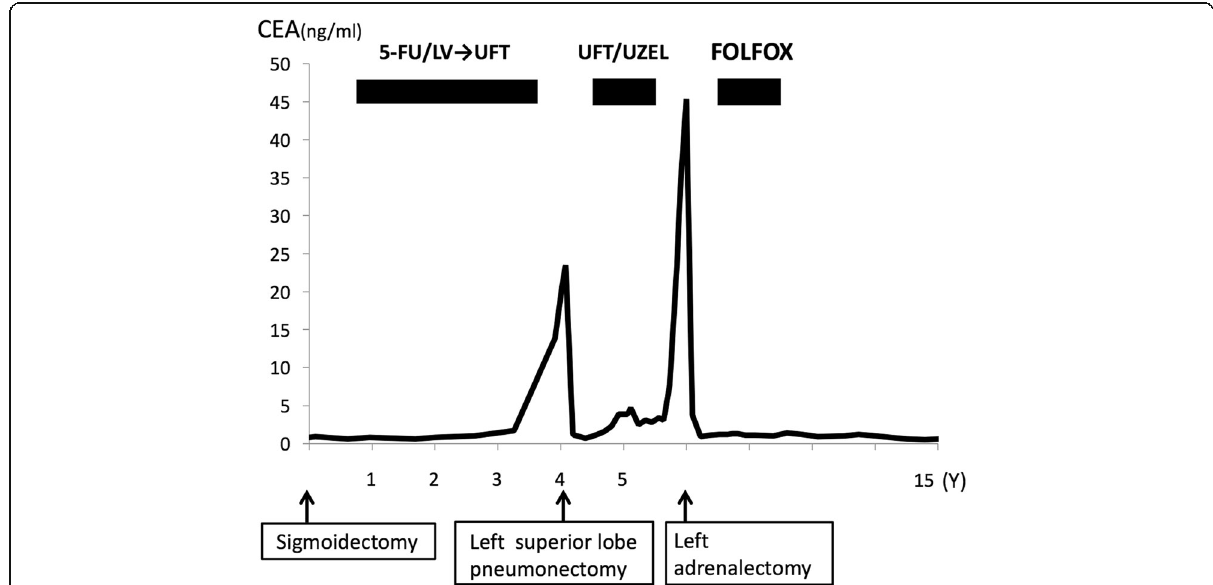
Fig. 4 The clinical course of Case 2. Vertical axis: CEA(ng/ml). Horizontal axis: time elapsed. M month(s). Y year(s). 5-FU 5-fluorouracil LV leucovorin. UFT tegafur-uracil. UZEL calcium folinate. FOLFOX infusional 5-fluorouracil, leucovorin,